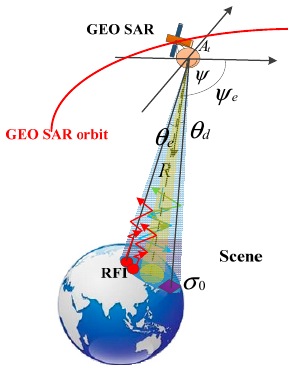
Figure 3. Sketch of GEO SAR system in the presence of RFI.